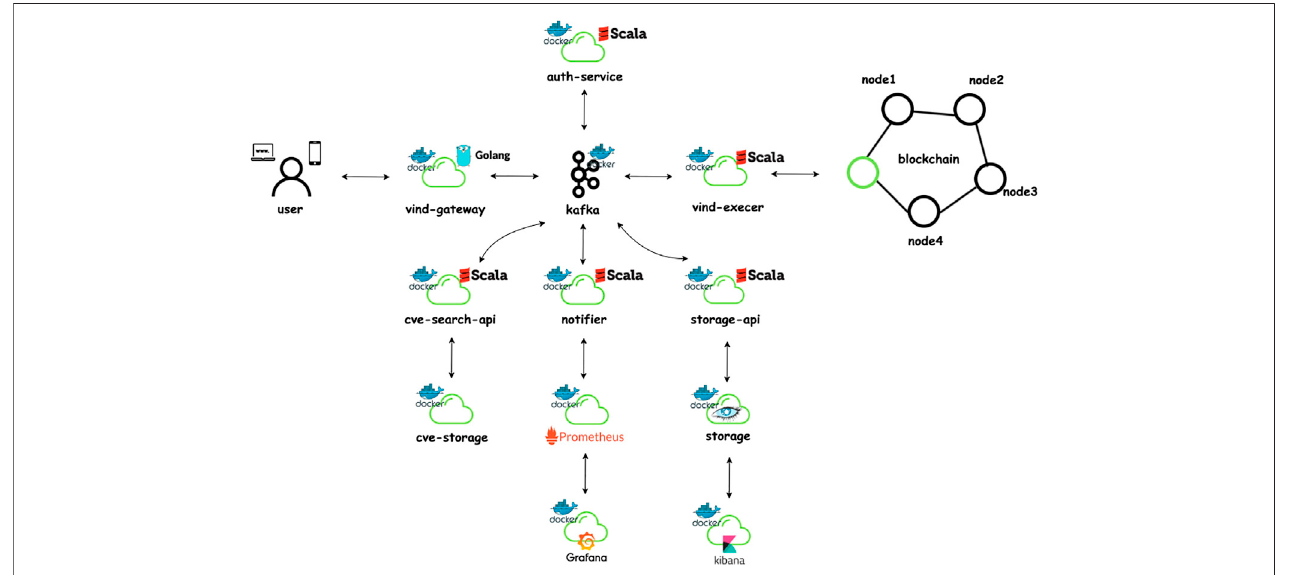
FIGURE 3 | Microservices-based architecture in the Vind platform. The platform is running as a permissioned blockchain system in a private cloud.